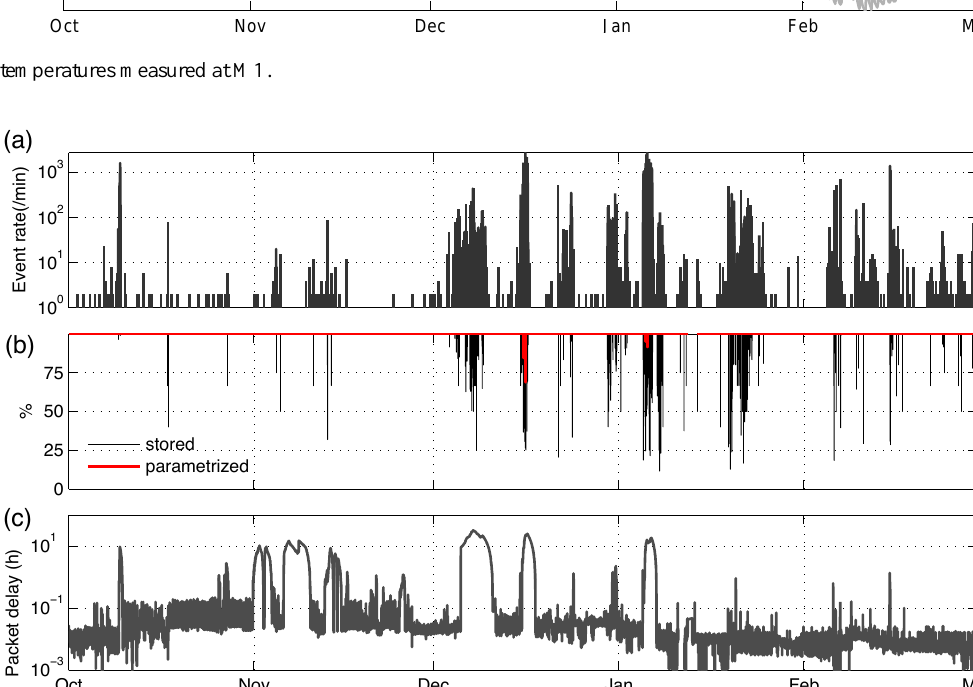
Fig. 11. Performance of the AE-node at M1: (a) rate of AE events measured, (b) percentage of all measured events that were parameterized, and fully stored (waveform), and (c) time elapse between generation of data packets and their transmission through the WSN.